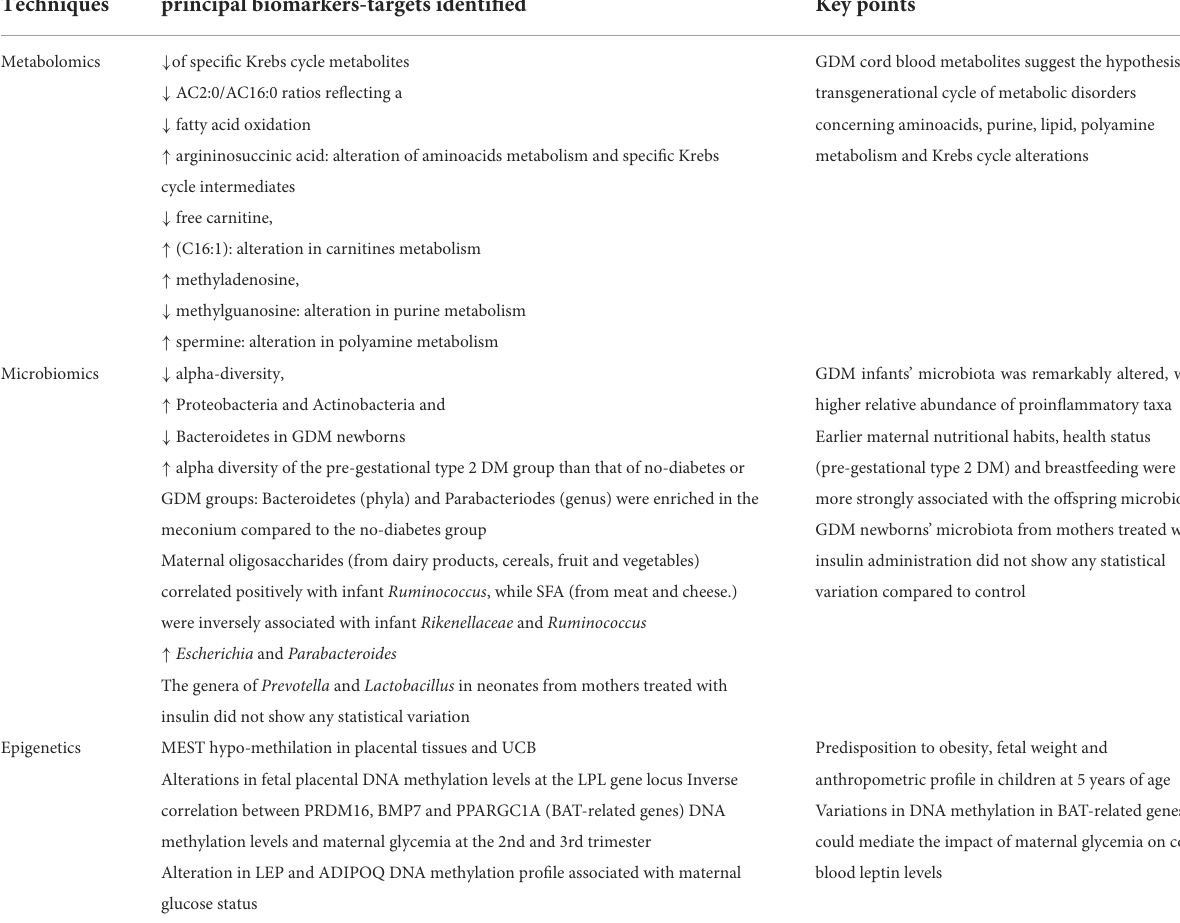
TABLE 4 Principal biomarkers-target identified in GDM offspring correlated with metabolic